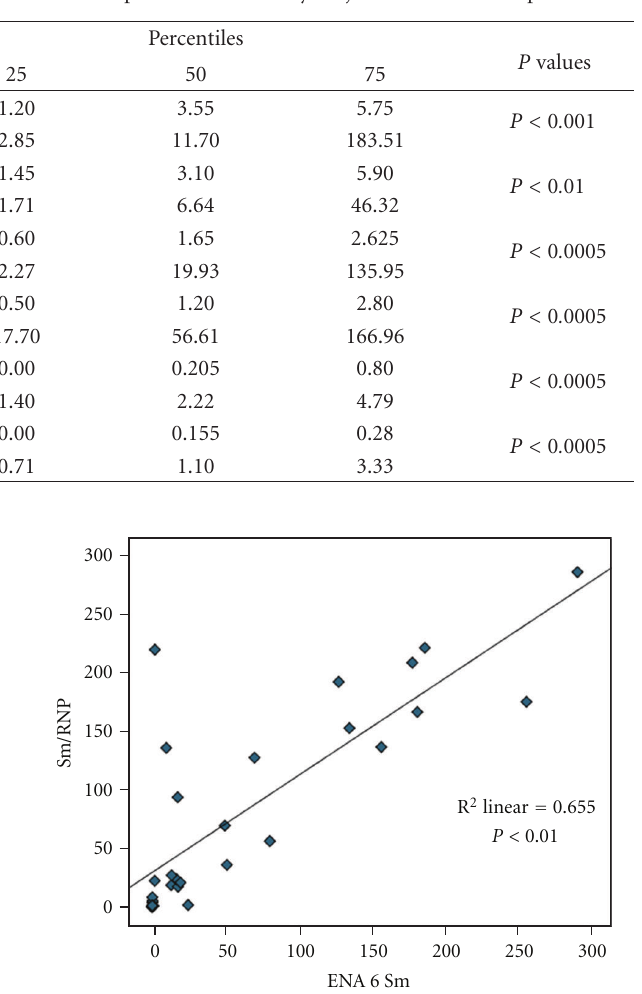
Figure 9: Spearman’s correlation analysis between ENA6 Sm and